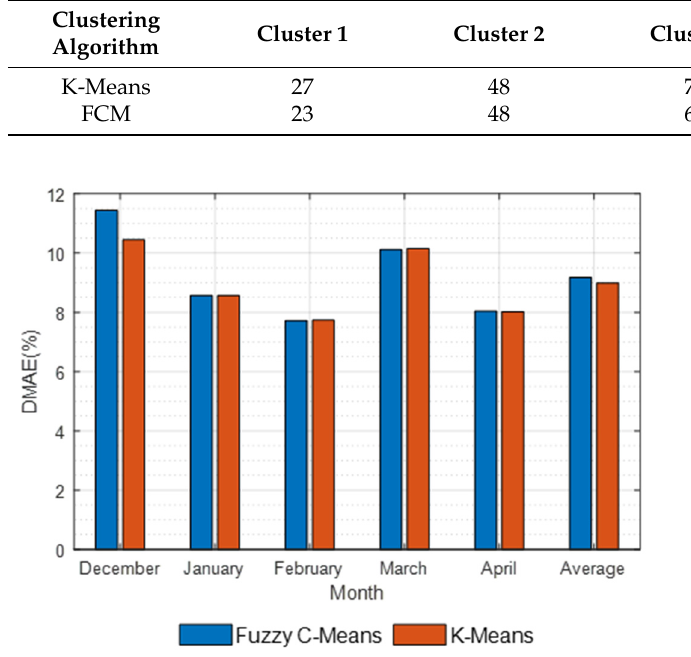
Figure 6. DMAE value of all the PV sites using the different clustering